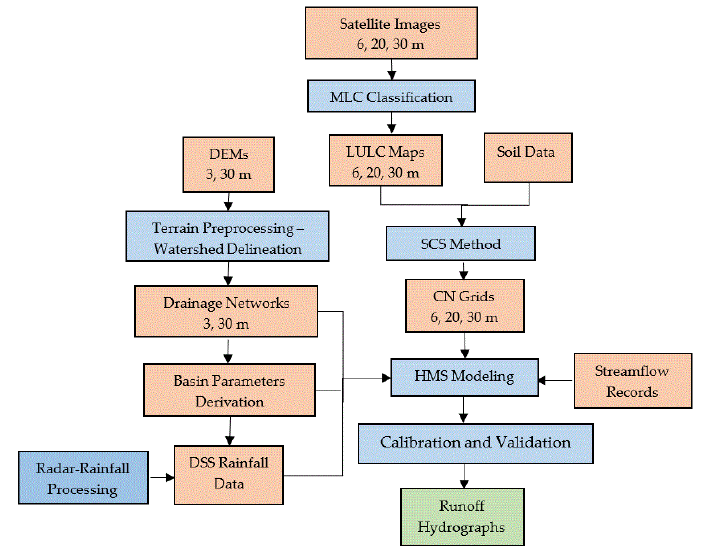
Figure 2. Data processing and modeling procedures: orange boxes indicate data inputs with different spatial resolutions, blue indicates processing, and green indicates final simulation outputs.